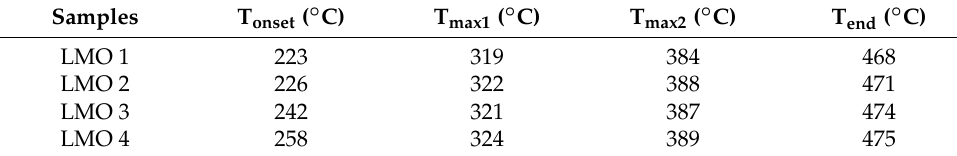
Table 11. Thermal degradation temperature of MREs with different ratios of LMO:AO.